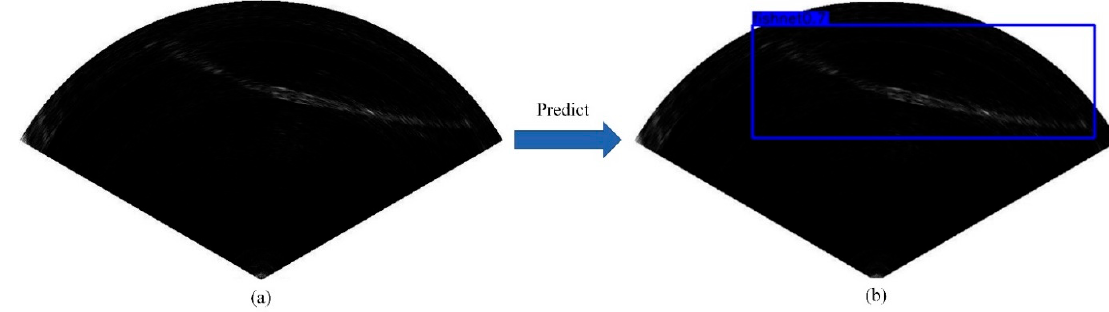
Figure 1. An example of object detection. ( a ) A test forward-looking sonar (FLS) image with a fishing net; ( b ) the predicted position of the fishing net in the image (blue box).